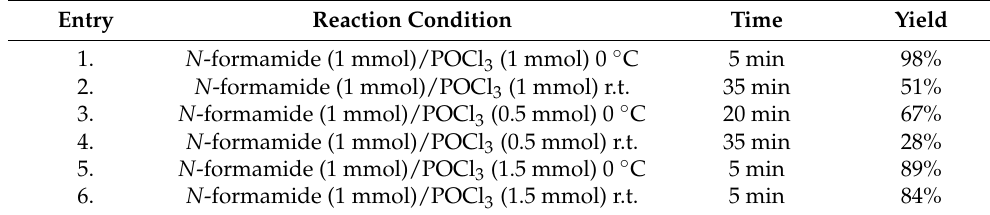
Table 3. Dehydration of N -(3-bromophenyl)formamide with POCl 3 under different molar and temperature